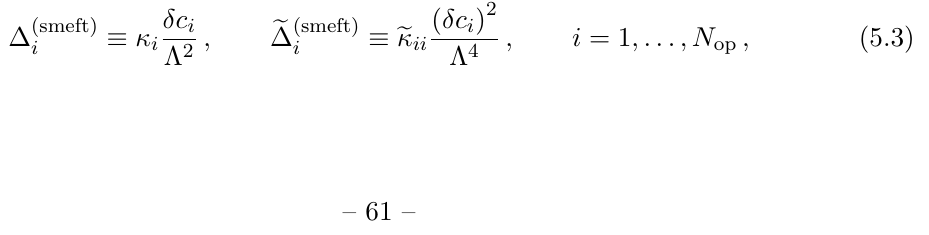
distributions. t (cid:22) t